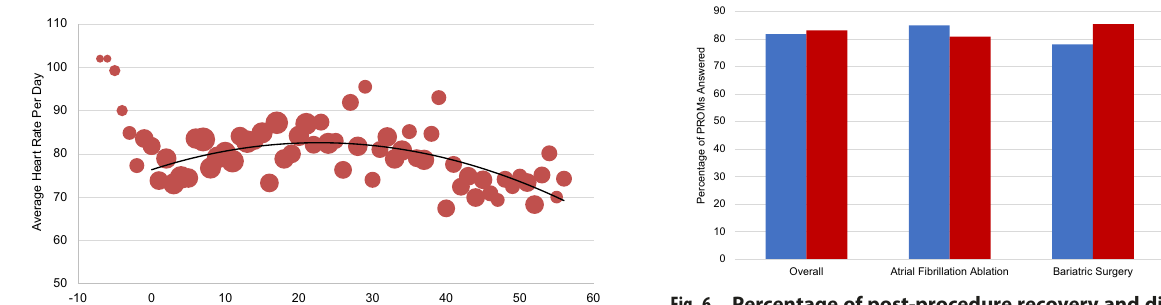
Fig. 6 Percentage of post-procedure recovery and disease-speci fi c patient-reported outcome measure questionnaires answered. Post-procedure recovery questionnaires were obtained twice weekly for a total ten questionnaires post-procedure. Disease-speci fi c questionnaires were obtained at 1, 4, and 8 weeks post-procedure. Data are strati fi ed by patients who underwent atrial fi brillation ablation and bariatric